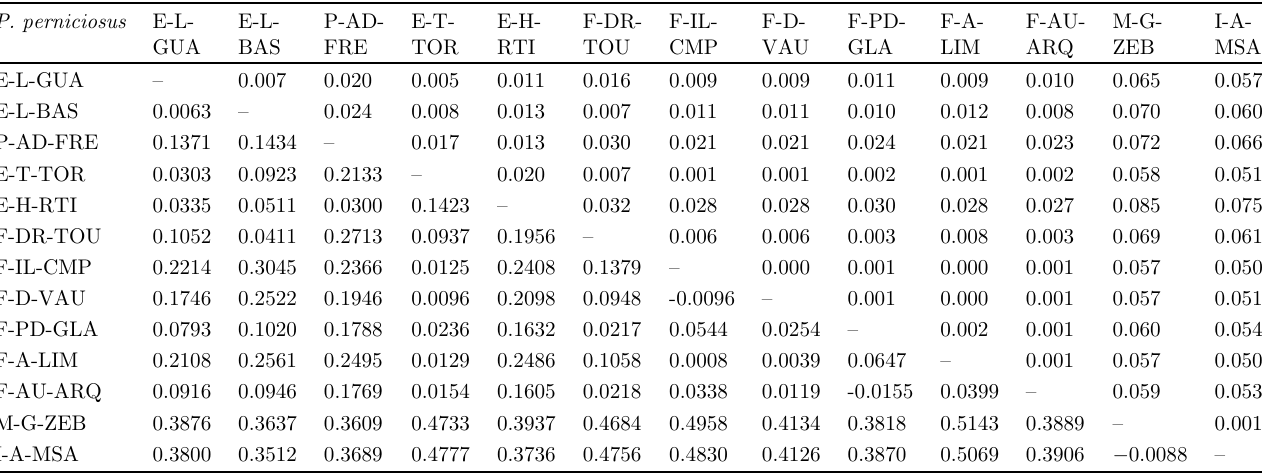
Table 2. Below diagonal: Fst values between each pair of populations were estimated using GENEPOP [34]. Above diagonal: Nei (1972) [27] genetic distance. Values calculated from the isoenzyme data at the seven polymorphic loci for the 13populations of P. perniciosus . Population codes are given in Table